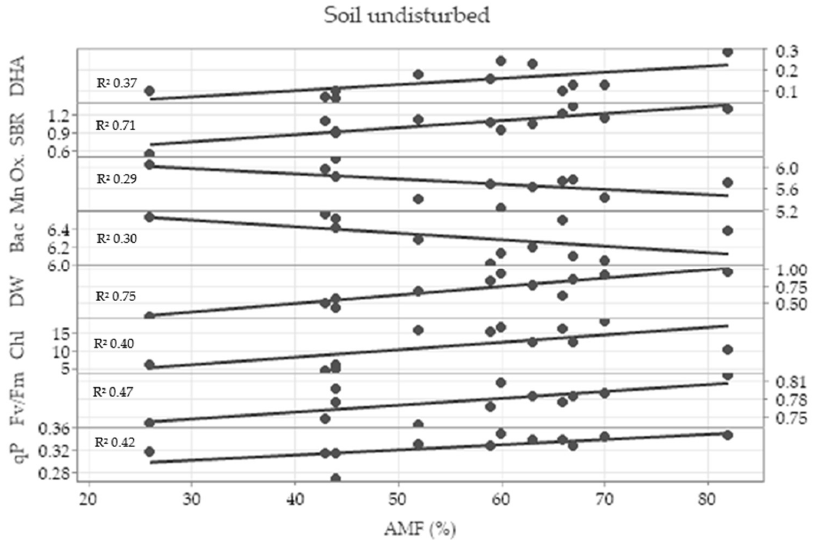
Figure 6. Linear regression analysis between wheat root colonization by arbuscular mycorrhizal fungi (AMF) and dehydrogenase activity (DHA), soil basal respiration (SBR), total bacteria (Bac), Mn oxidizers (Mn Ox.), shoot dry weight (DW), chlorophyll content (Chl), maximum quantum efficiency of photosystem II (Fv/Fm) and photochemical quenching (qP) in the undisturbed treatment with the coefficient of linear regression (R 2 ).